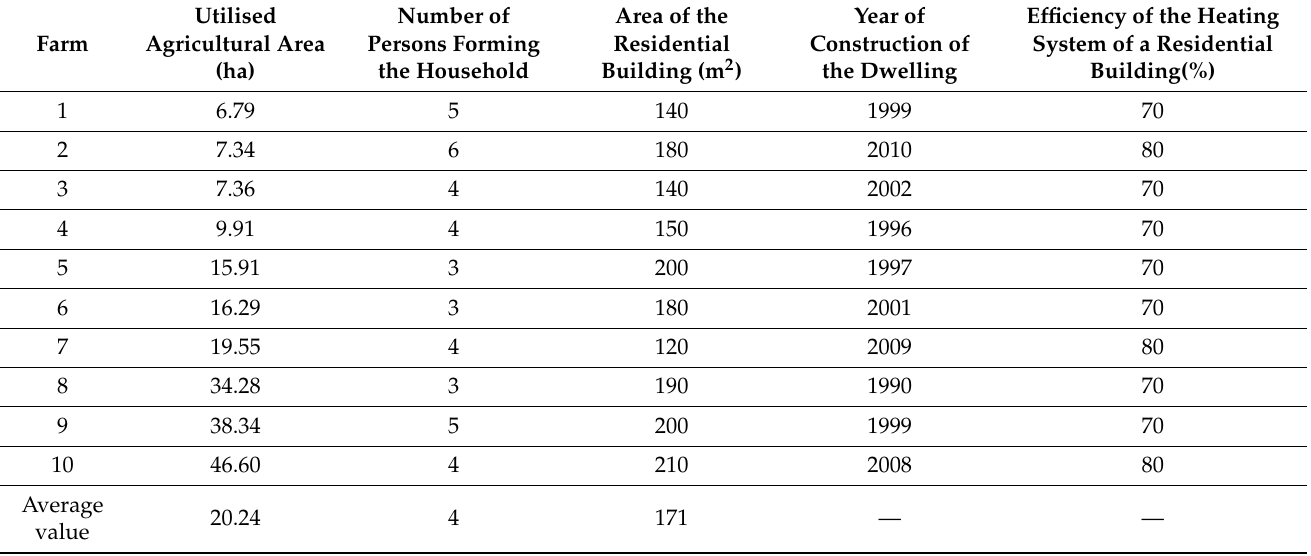
Table 1. Selected characteristics of the surveyed